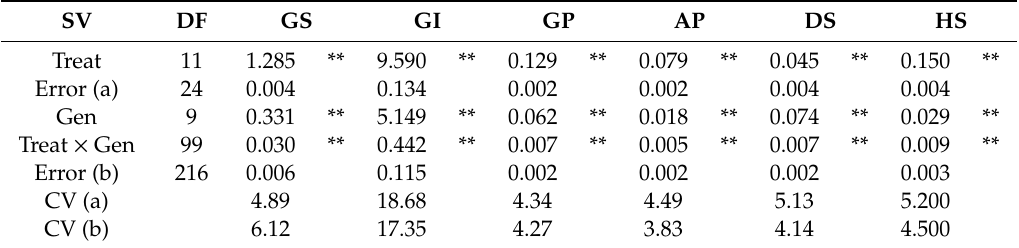
Table 3. Mean squares of the analysis of variance of physiological variables.